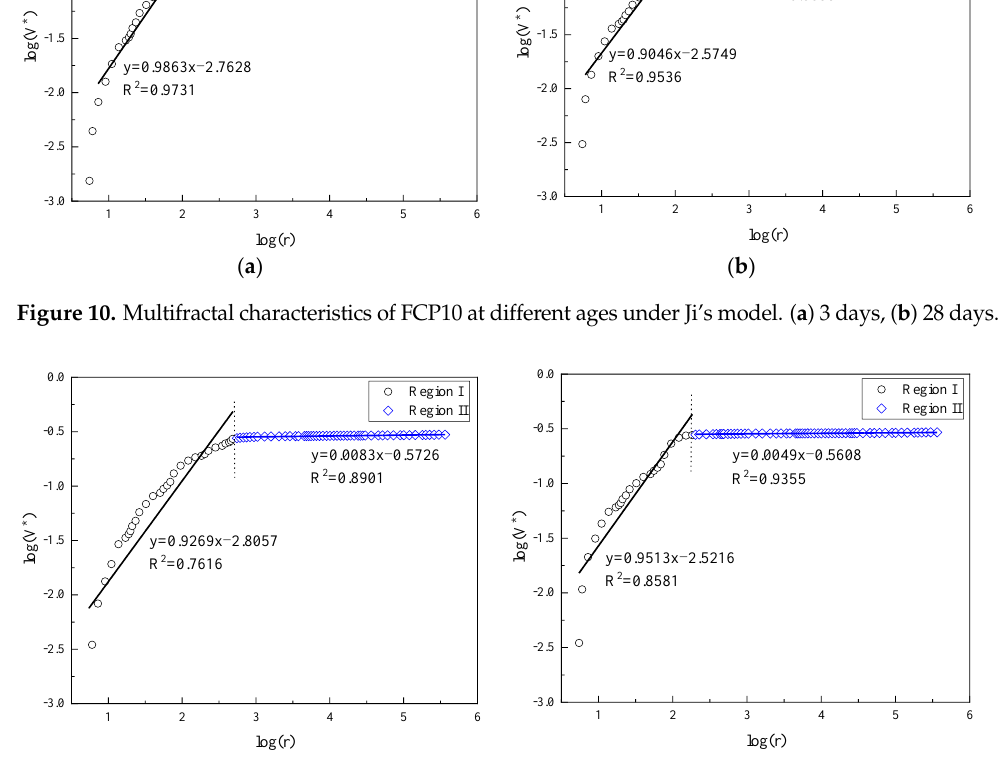
Figure 11. Multifractal characteristics of FCP30 at different ages under Ji’s model. ( a ) 3 days, ( b ) 28 days.